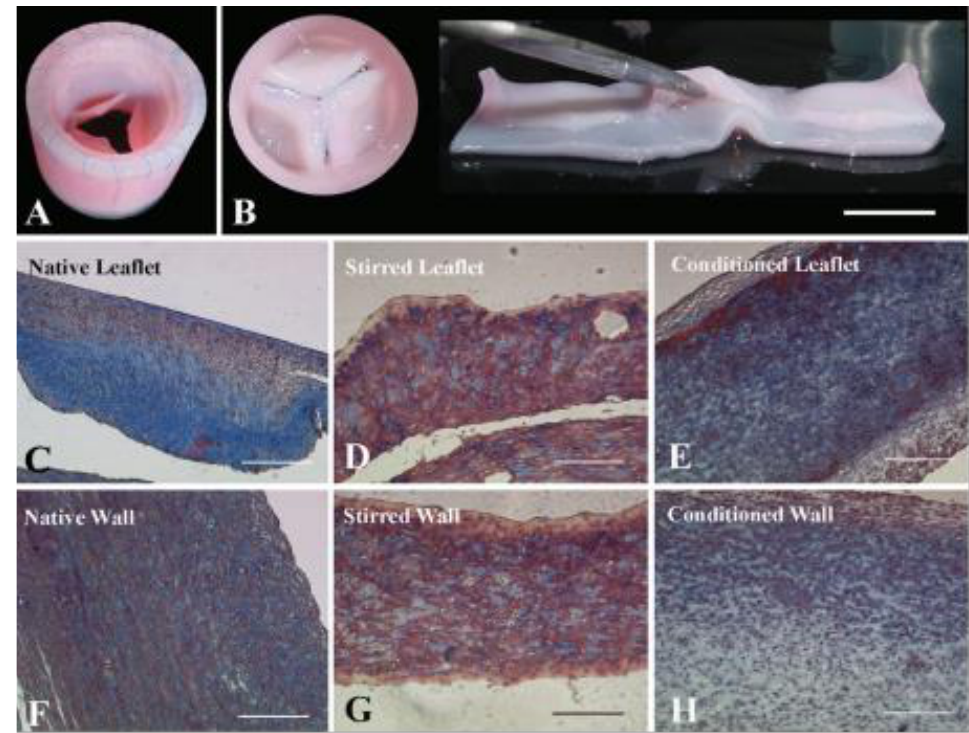
Figure 19. ( A ) Gross appearance of the heart valve after removal from the bioreactor. ( B ) The fibrin-based valves (left: outflow side of closed valve; right: opened conduit cut through conduit wall following removal of the silicone cylinder). Scale: 10 mm. ( C – H ) Histological micrographs of trichrome-stained samples: ( C , F ) native ovine aortic valve leaflet and aortic wall; ( E , H ) conditioned leaflet and wall; ( D , G ) stirred tissue samples. Scale: 250 mm. Reprinted with permission from ref. [234]. Copyright 2007, Elsevier.